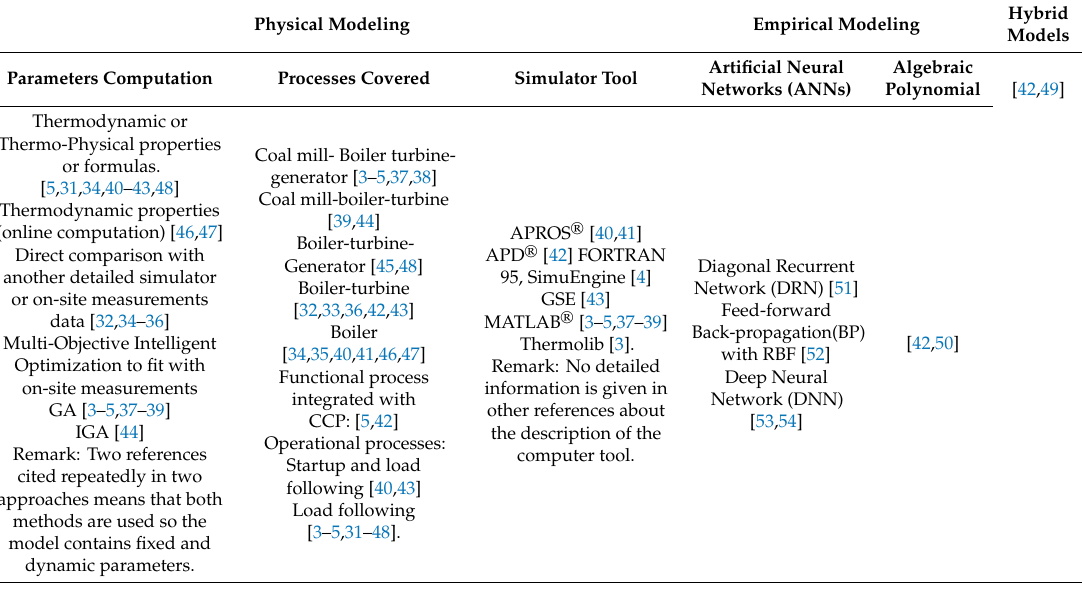
Table 1. Modeling review summary (coverage